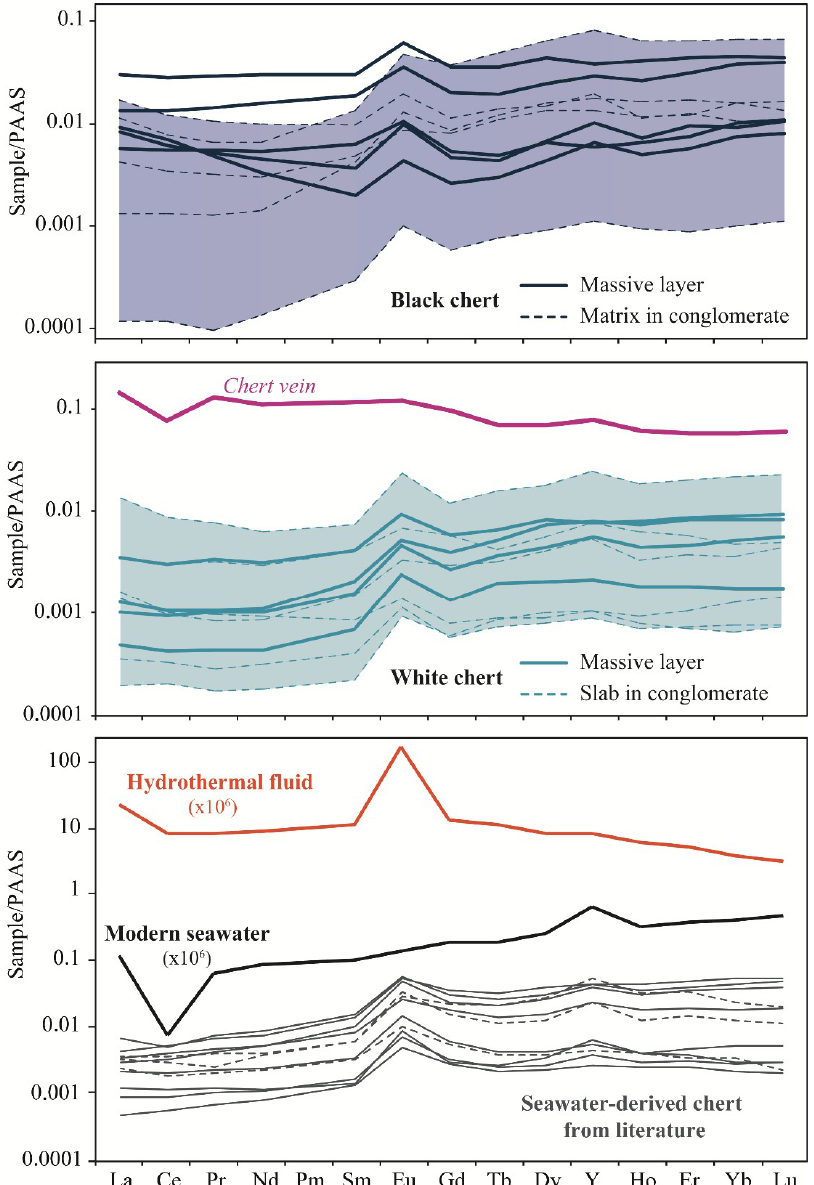
Figure 15. REE + Y patterns for Buck Reef black and white chert and one chert vein (BRC2-V). All patterns are normalized to Post-Archaean Australian Shale (PAAS) [42]. Samarium in white samples is a corrected value calculated as Sm* = (2/3 Nd SN ) + (1/3 Gd SN ) (see Supplementary Material for a discussion of the Sm anomaly). The composition of average Pacific seawater [43], Mid-Atlantic Ridge hydrothermal fluids (180–360 °C; [44) and seawater derived chert from the Pangola BIFs (plain line, [45), and the Marble Bar units (dotted line, [20]) are shown for comparison.